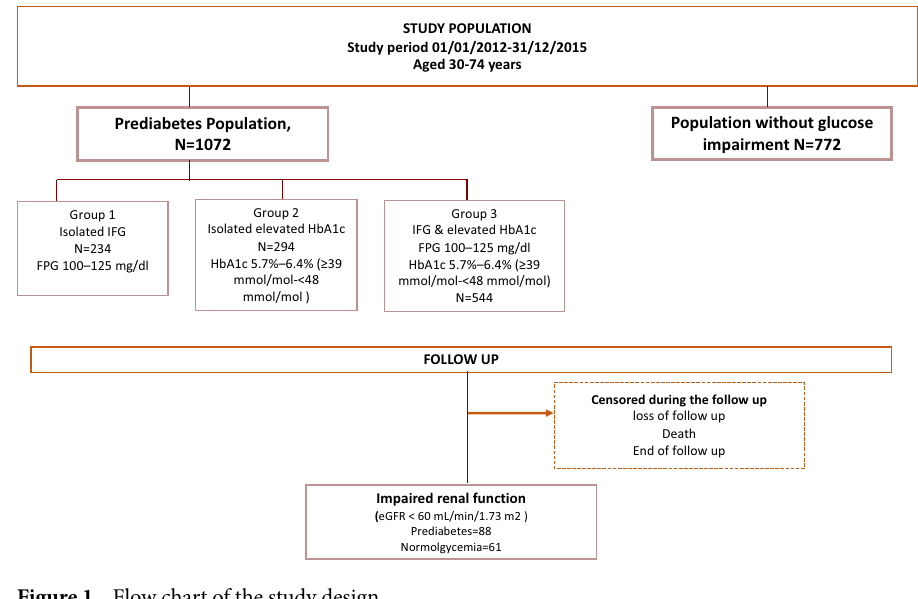
Figure 1. Flow chart of the study